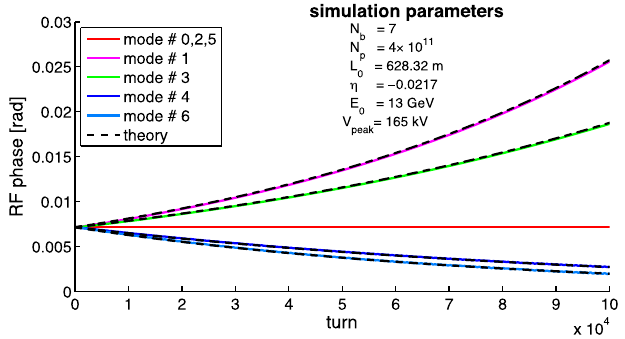
FIG. 2. Amplitude of the multibunch oscillation modes as a function of the number of turns given by M U S I C and compared with the linear theory. Each bunch is supposed to be a rigid macroparticle.